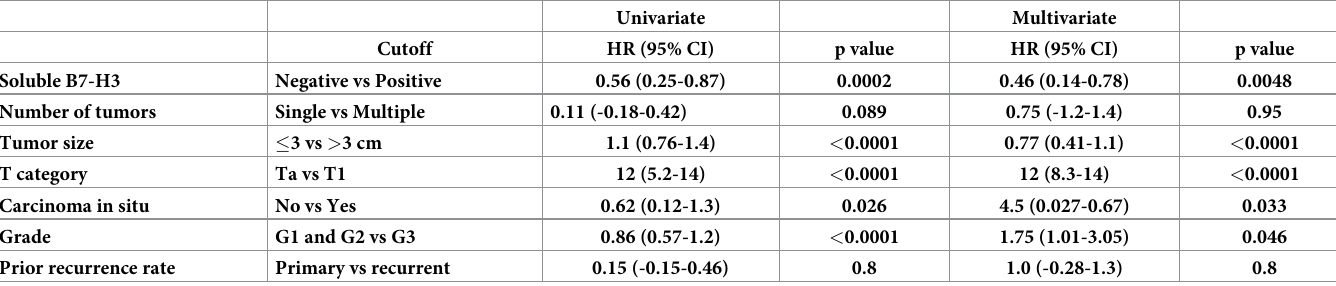
Table 4. Univariate and multivariate analysis of